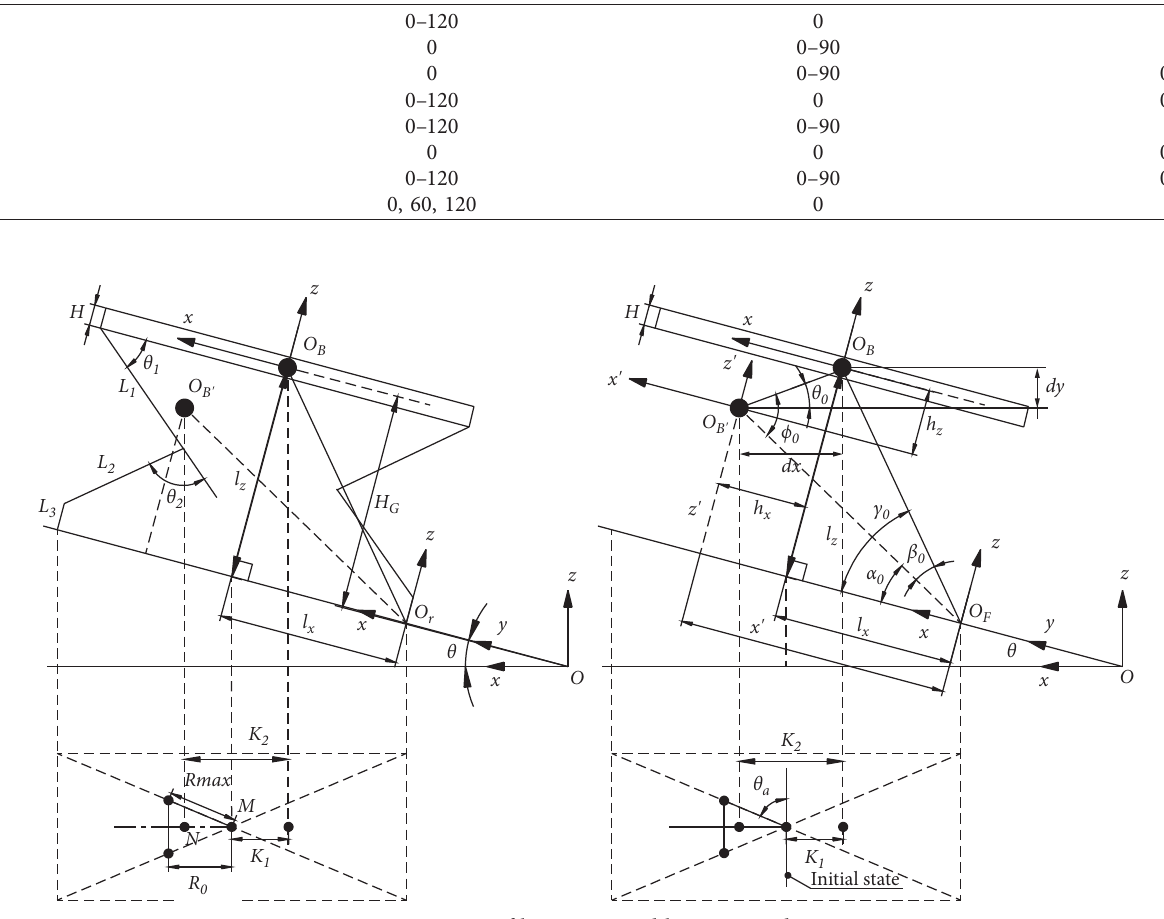
Figure 3: Projection of barycenter and barycenter adjustment.